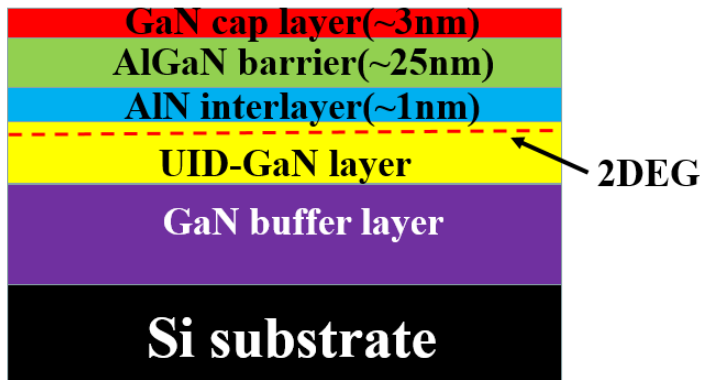
Figure 1. Schematic AlGaN/GaN-on Si device structure.